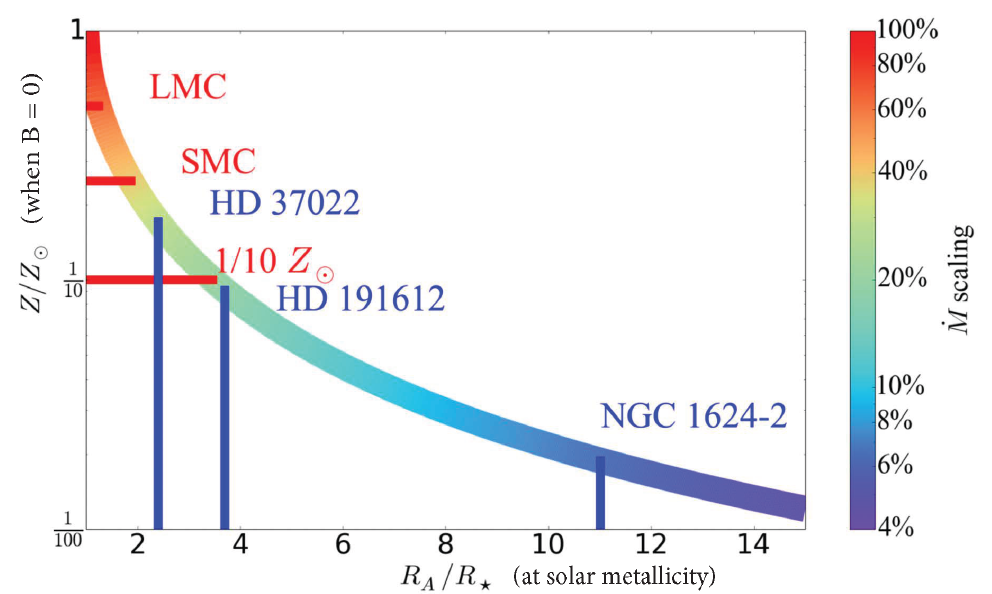
Figure 3. Equivalency curve between different physical processes leading to a reduction in stellar mass-loss rates (colour-coded). The horizontal axis shows the Alfvén radius (in units of the stellar radius), quantifying the strength of the magnetic field. It is considered at solar metallicity. Some known magnetic massive stars at solar metallicity are included for reference. The vertical axis shows the effect of metallicity for a non-magnetic case. For reference, the Large and Small Magellanic Clouds (LMC and SMC, respectively) are indicated. The first LIGO detection was inferred at 1/10 of solar metallicity. Adopted from Figure 7.2 of